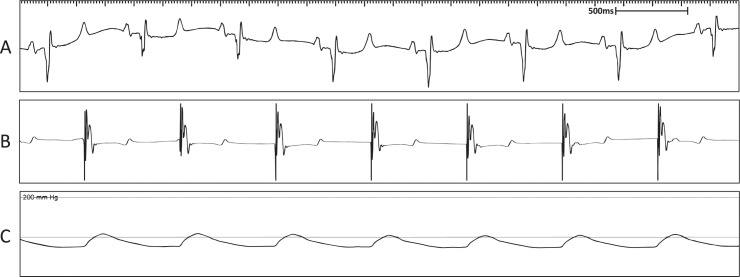
Representative surface ECG recordings during the pacemaker implantation to confirm lead placement.(A) Surface ECG depicting normal sinus rhythm under anaesthesia. (B) Surface ECG depicting paced rhythm during pacemaker diagnostics. (C) Mean arterial pressure trace indicating maintenance of blood pressure throughout the procedure.